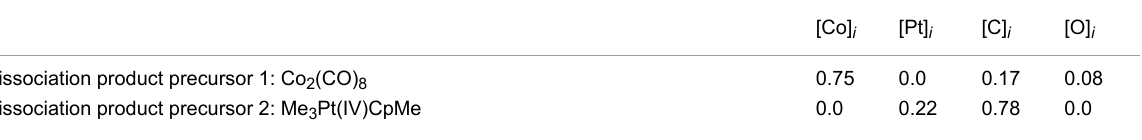
Table 3: Composition of nonvolatile dissociation products from the individual precursors Co 2 (CO) 8 and Me 3 Pt(IV)CpMe on Si/SiO 2 substrates at 5 keV beam energy, 1.6 nA beam current (measured at Faraday cup), 20 nm pitch and 1 μ s dwell